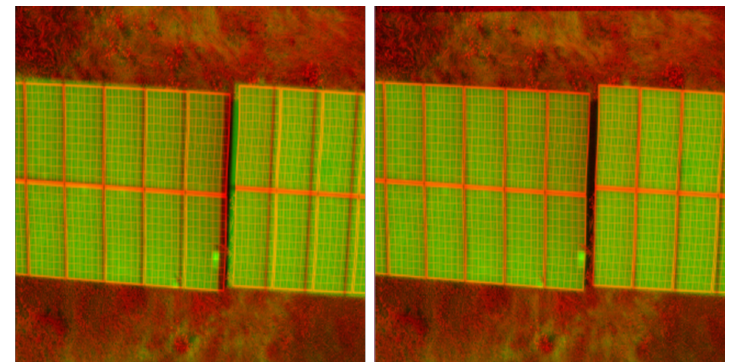
Figure 9. ( left ) Image before registration; and ( right ) image after registration.